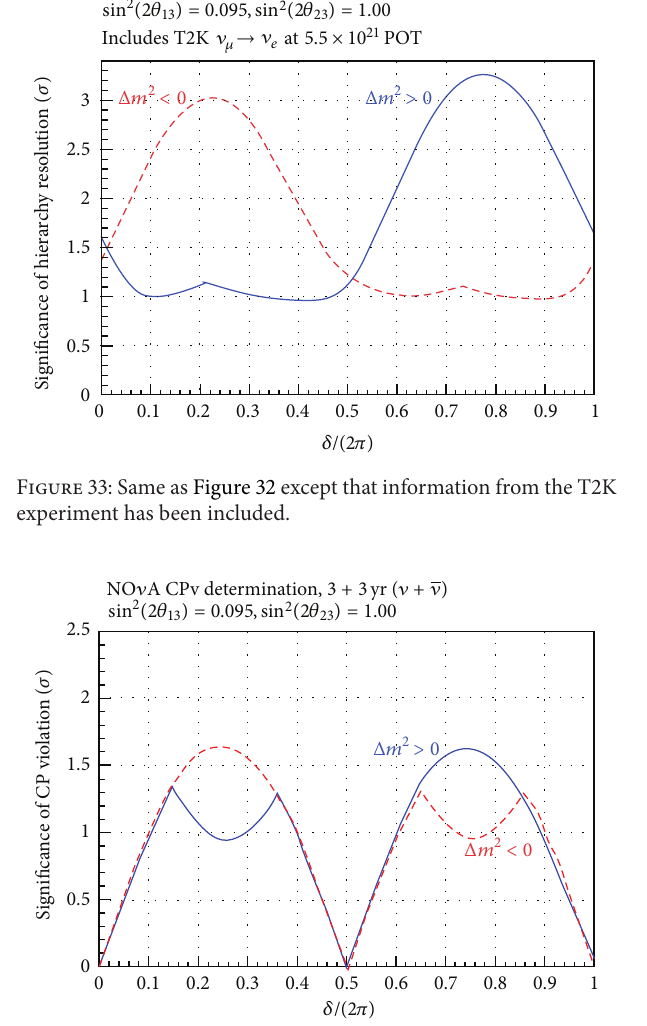
Figure 34: Significance of the determination that CP violation occurs in neutrino oscillations as a function of 𝛿 in standard deviations. These sensitivities are for NO 𝜈 A alone for the two possible orderings and sin 2 (2𝜃 23 ) = 1.0 . The significance goes to zero at 𝛿 = 0 and 𝛿 = 𝜋 since there is no CP violation at those points. The dips in the peaks occur because the mass ordering has not been resolved for the ordering containing the dips.